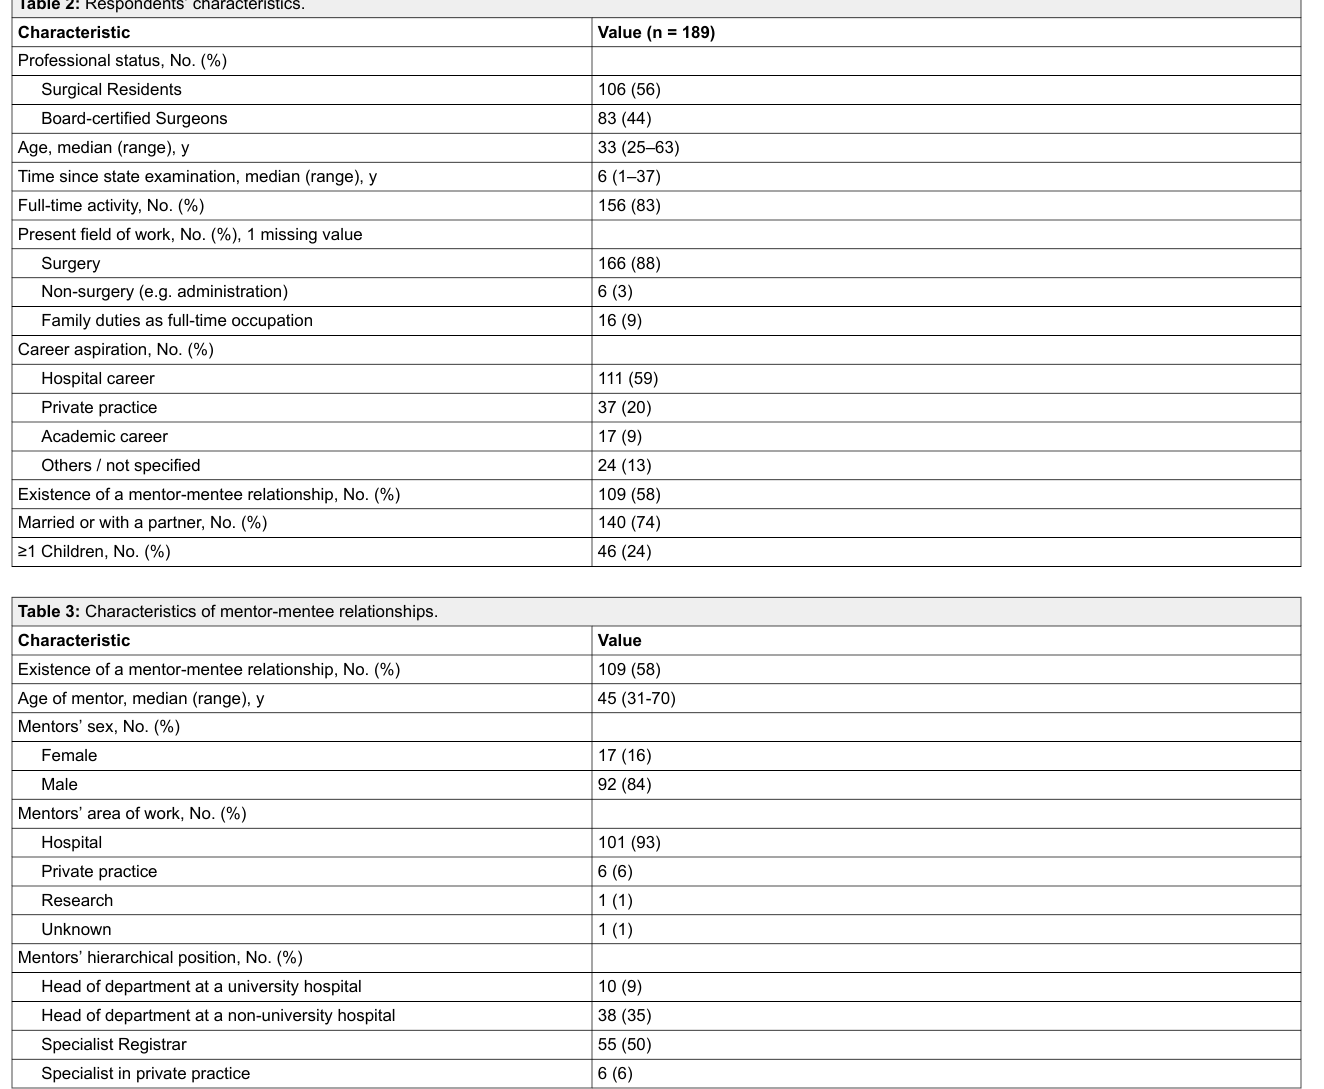
Table 2: Respondents’ characteristics.